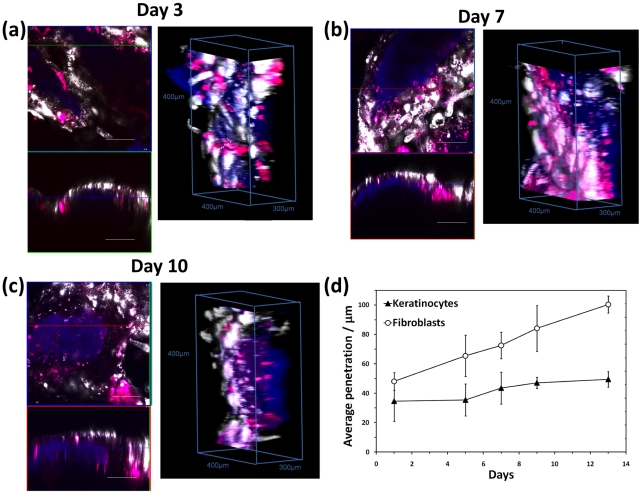
Tracking different cell types in 3D models.(a) Tissue-engineered human oral mucosa imaged by confocal laser scanning microscopy after 3 days, (b) 7 days and (c) 10 days. The keratinocytes (HOKs) and the fibroblasts (HOFs) that comprise the mucosa were previously stained by incubating the cells with Rhodamine B octadecyl ester- (red) and (1,1′-Dioctadecyl-3,3,3′,3′-tetramethylindodicarbocyanine perchlorate)- (white) loaded polymersomes. (d) The blue channel shows endogenous autofluorescence from the connective tissue component 3D cell imaging allows the extent of dye permeation to be determined over time (error bar = SEM, n = 3). Between 90 and 110 slices were acquired for each image. Slice thickness 0.003 mm.